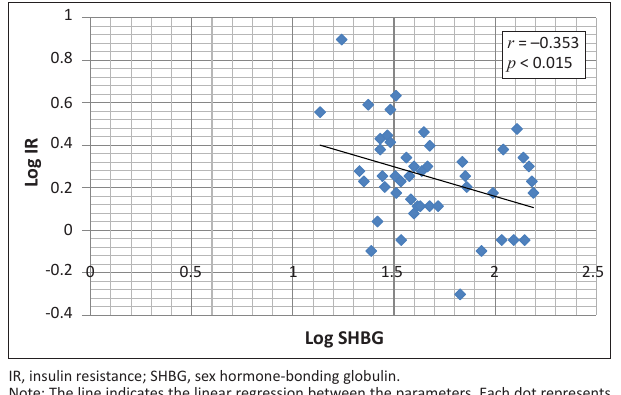
r = –0.353 p < 0.015